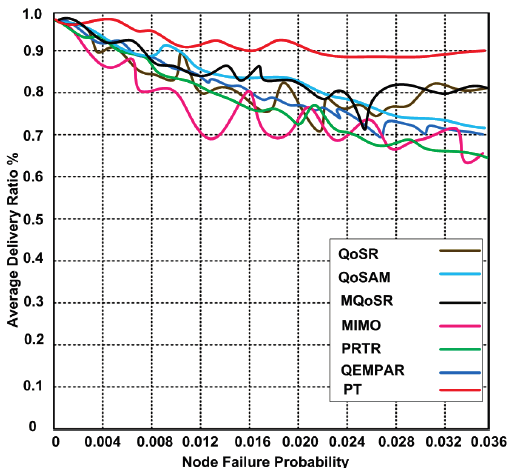
Figure 6. Average delivery ratios vs. different node failure probability.